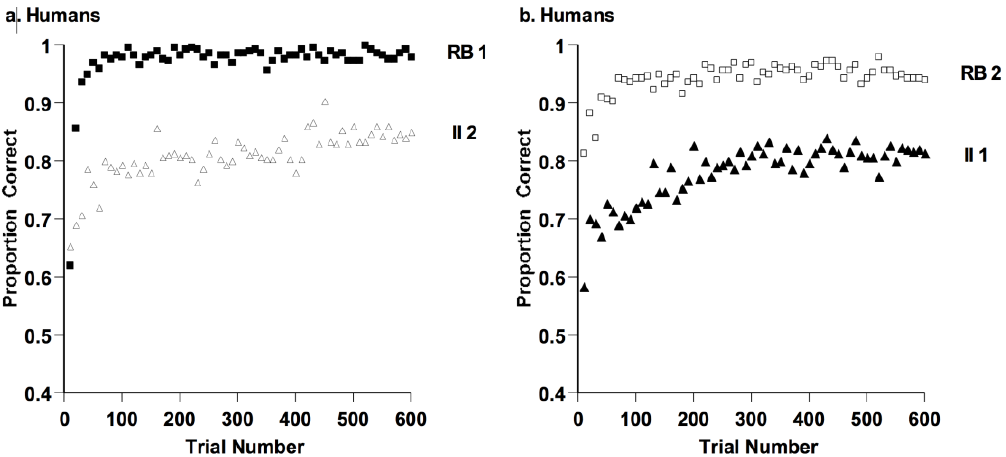
Figure 13. (a) Proportion of correct responses in each 10-trial block for 30 humans who performed 600 trials of a rule-based (RB) and an information-integration (II) category task, in that order; (b) Proportion of correct responses in each 10-trial block for 30 humans who performed 600 trials of an II and RB category task, in that order. Reprinted from [58]. Copyright 2012 by Elsevier. Reprinted with permission.